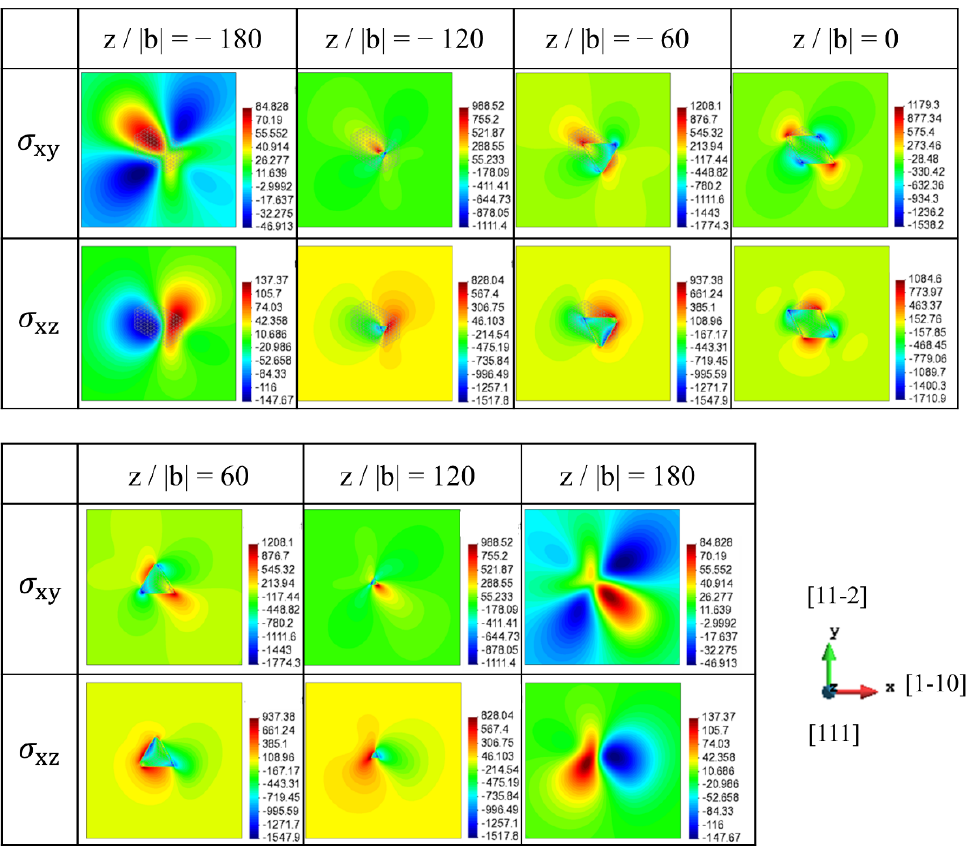
Figure 4. Stress field of [010] rod on the (111) slip plane (Type-B variant). σ xy and σ xz in dislocation coordinate are represented at the different positions (z/|b| = −180 to 180).